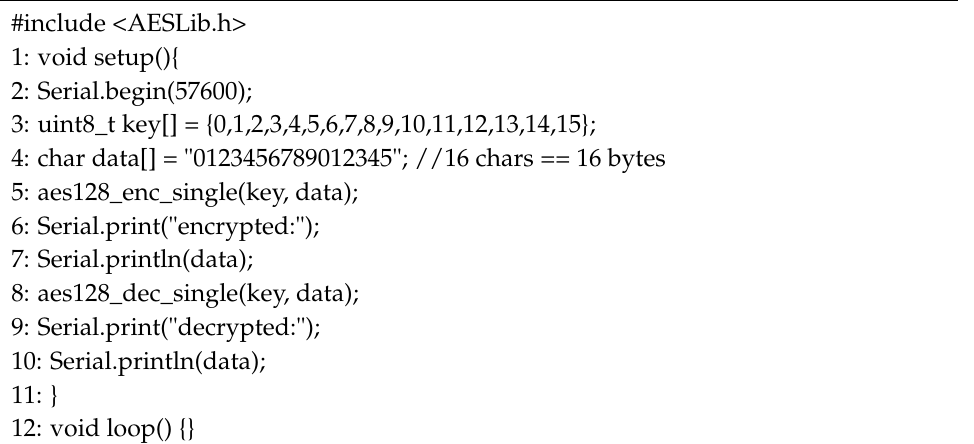
Algorithm 1: Source code for the AES algorithm on Arduino Mega #include